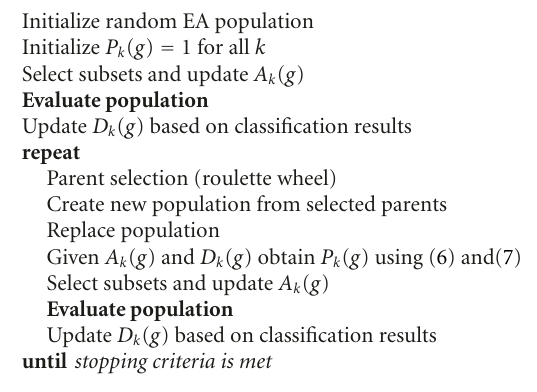
Algorithm 1: Optimization for